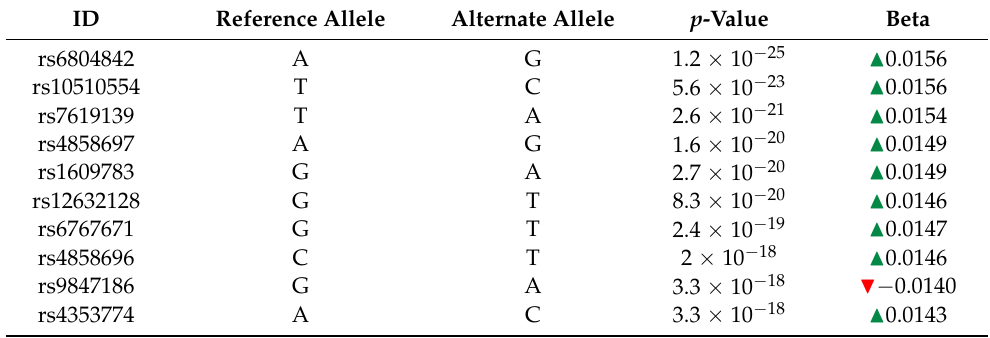
Table 1. Association of most significant variant (BMI) in RAR β obtained from the T2D knowledge